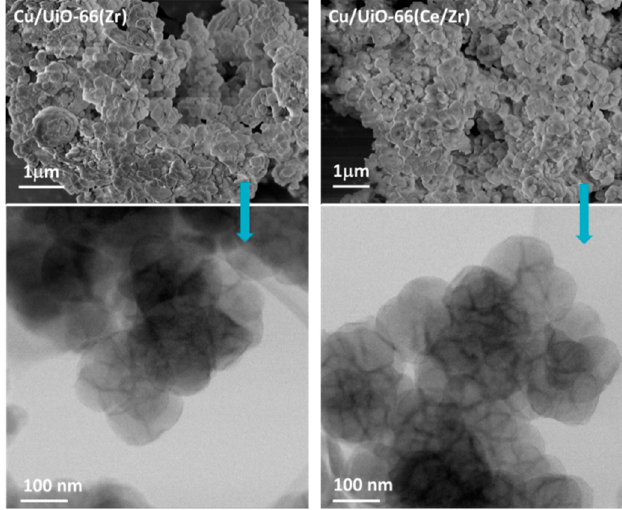
Figure 5. Scanning electron microscope (SEM) (up) and STEM (down) images of Cu/UiO-66(Zr) (left) and Cu/UiO-66(Ce/Zr) (right).